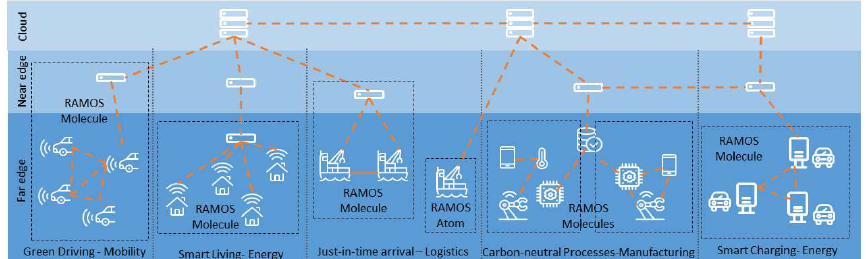
Figure 4. RAMOS components in diverse domain scenarios, illustrating the different orchestration, communication and data sharing